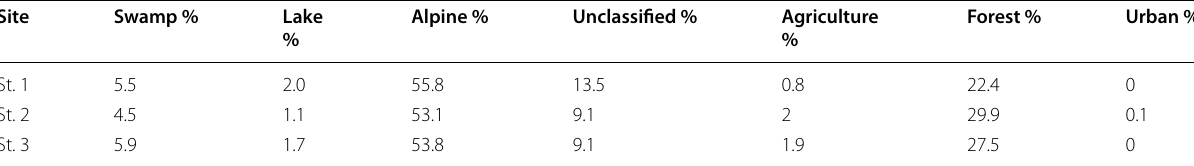
Table 2 Percentage of different land use in the catchment of each of the three sampling sites Site Swamp % Lake